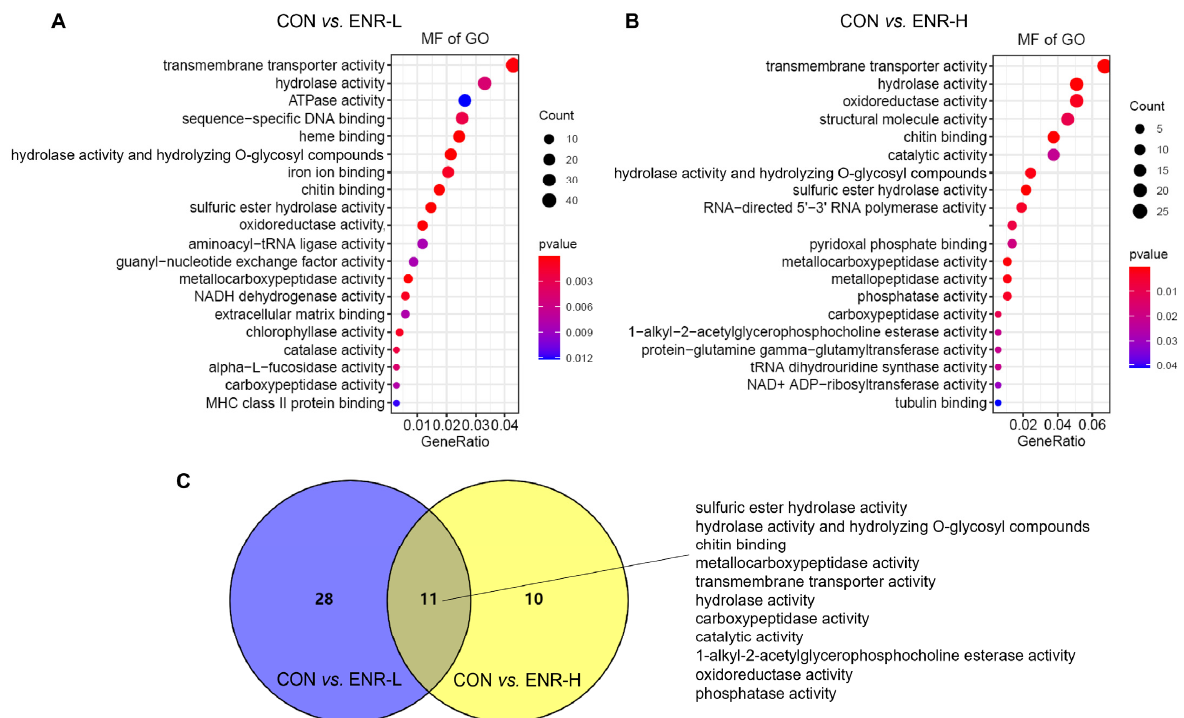
Figure 4. Gene ontology (GO) analysis of the DEGs in E. sinensis hepatopancreas samples following different exposure doses of enrofloxacin. Colors represent p -values. The x-axis represents the gene ratio. The y-axis represents GO terms involved in molecular functions. Venn diagrams showing number of molecular functions in E. sinensis hepatopancreas samples following ( A ) low and ( B ) high exposure doses. ( C ) Enrichment of DEGs of the common molecular functions affected by both low (blue) and high (yellow) enrofloxacin exposure